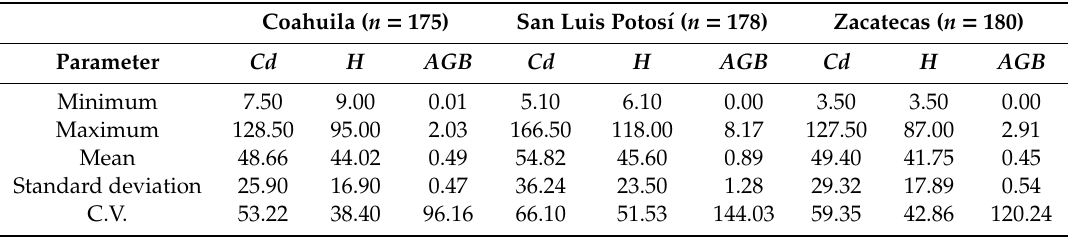
Table 1. Agave lechuguilla Torr. descriptive statistics of the variables evaluated in Mexico. Coahuila ( n = 175) San Luis Potos í ( n = 178) Zacatecas ( n = 180) Parameter